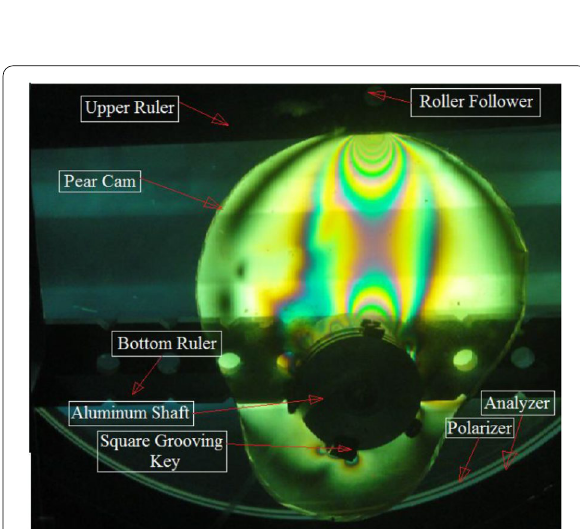
Figure 17 Stress analysis when the follower located at 180° with the